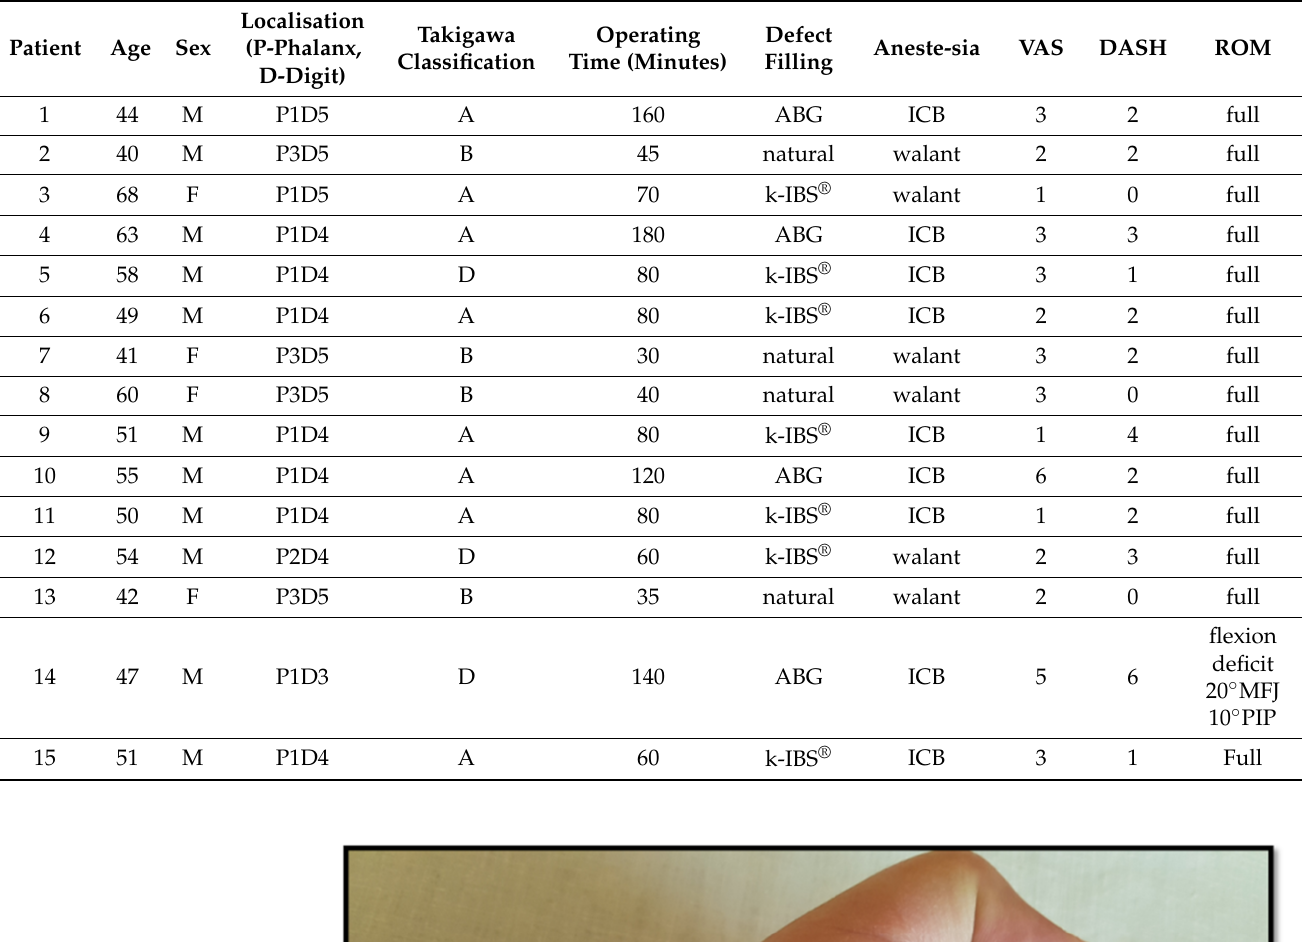
Table 1. Demografic and anatomic variables. Surgical technique and results. P—phalanx, D—digit, ABG—Autologous bone graft, ICB—Infraclavicular bloc.